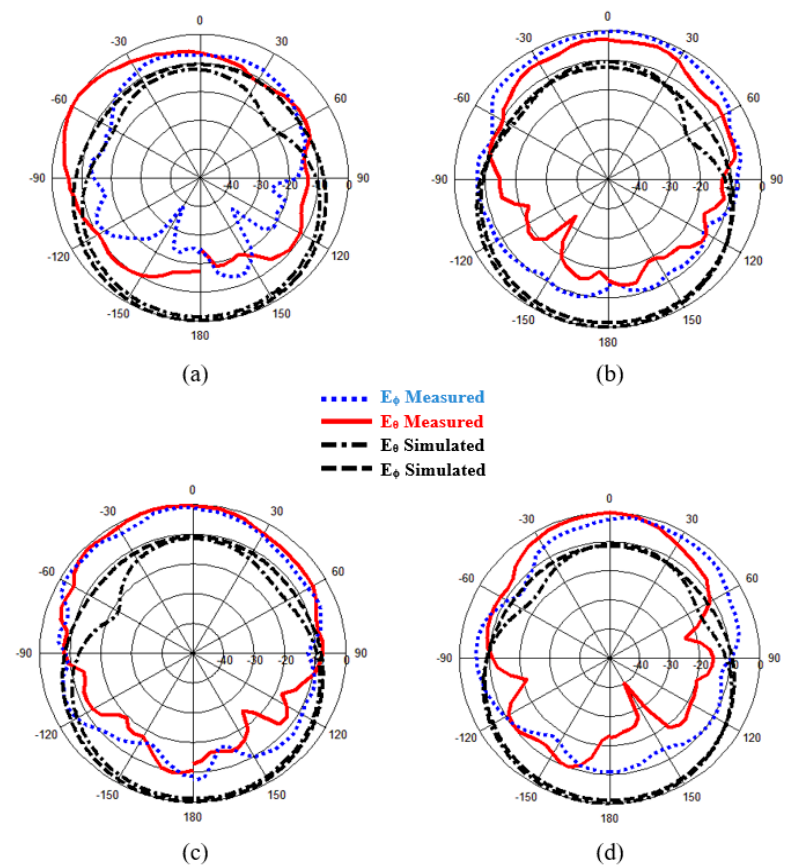
Figure 7. Simulated and measured radiation patterns of the proposed polarization-reconfigurable antenna: ( a ) ON-OFF state, xz plane; ( b ) ON-OFF state, yz plane; ( c ) OFF-ON state, xz plane; ( d ) OFF-ON state, yz plane.